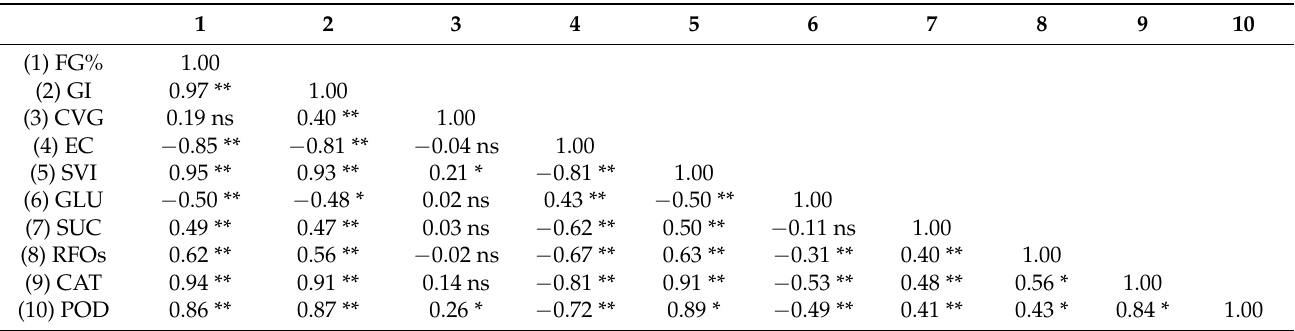
Table 3. Pearson correlations among seed and seedling quality parameters of production environments × maturity stages.